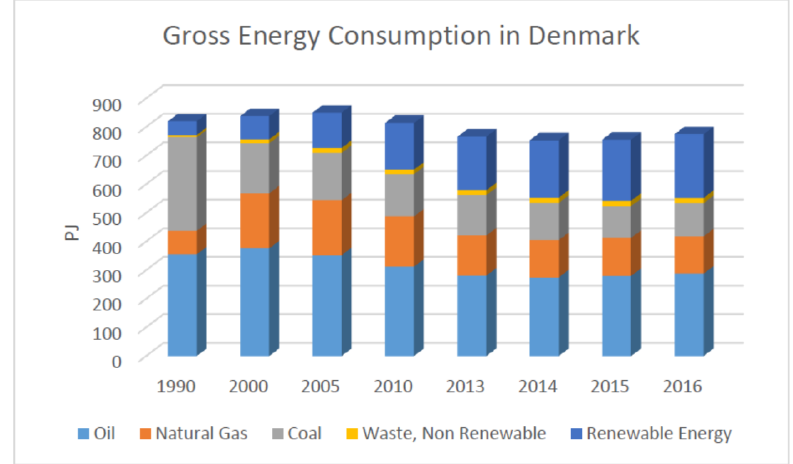
Figure 1. Gross energy consumption in Denmark (data from the Danish Energy Agency).